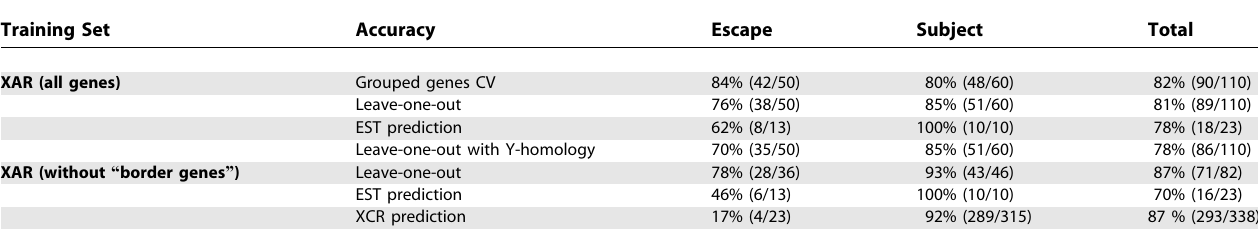
Table 2. Classification Accuracy for XAR Genes, XAR ESTs, and XCR Genes Using 5,596 Features from 50-kb and 100-kb Windows around Transcription Start Sites of the